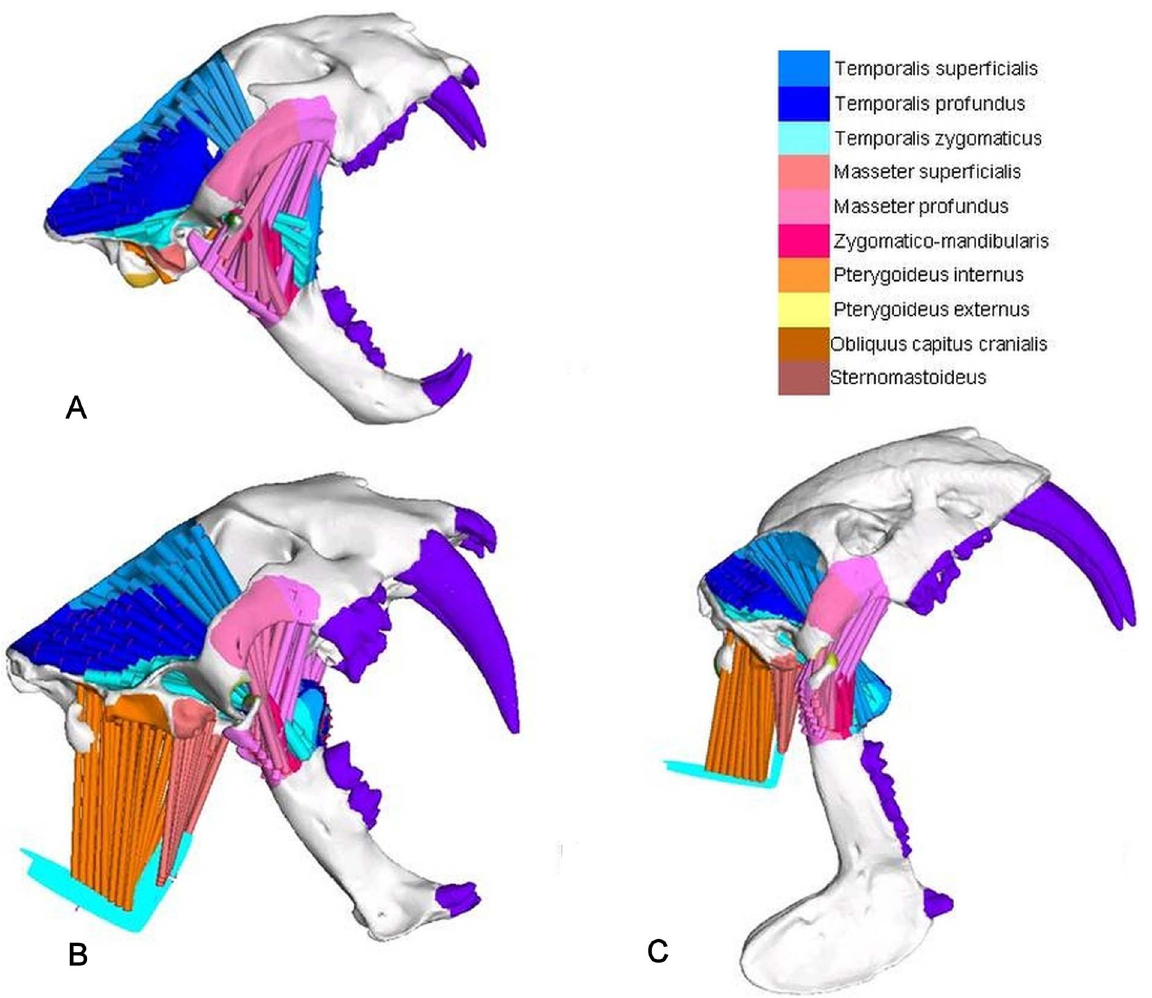
Figure 4. Muscle simulations. (A) jaw-adducting muscles in Panthera pardus , (B) head depressing and jaw-adducting muscles in Smilodon fatalis , and (C) head-depressing and jaw-adducting muscles in Thylacosmilus atrox .